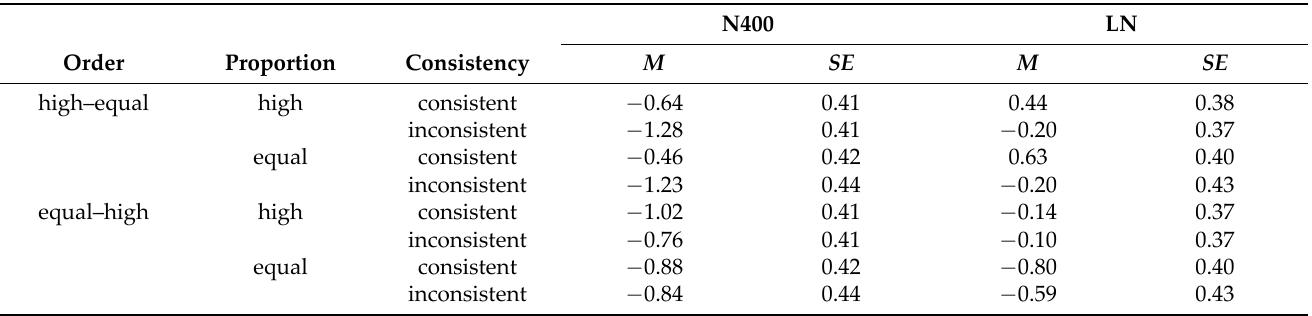
Table 2. Estimated marginal means ( M , µ V) and standard errors ( SE ) of N400 and LN amplitudes as a function of order, proportion, and consistency.